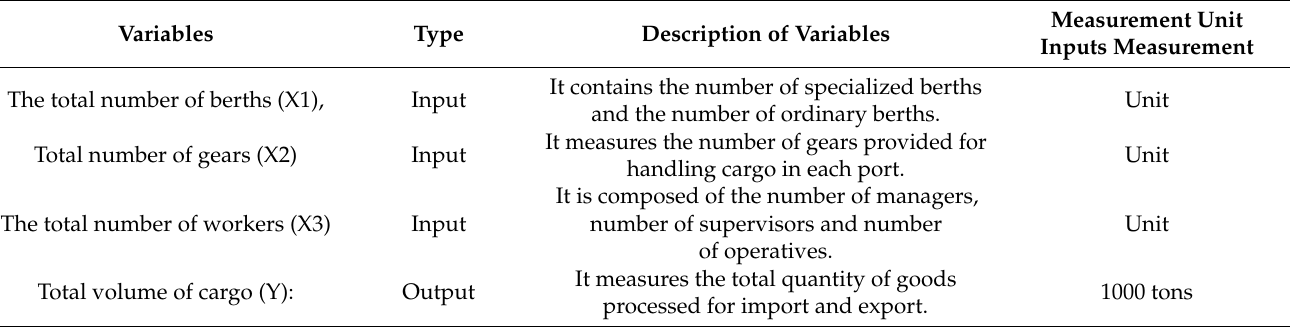
Table 2. Input and output variables